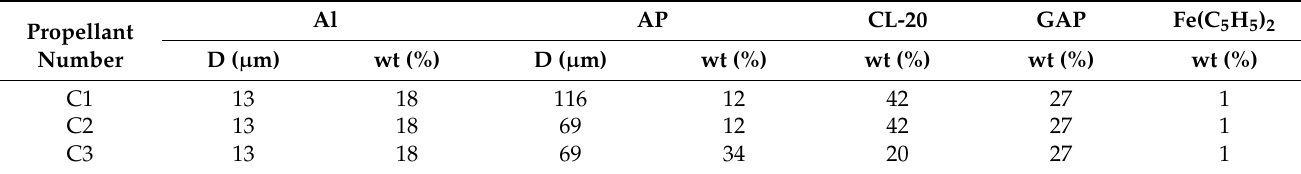
Table 1. Propellant sample